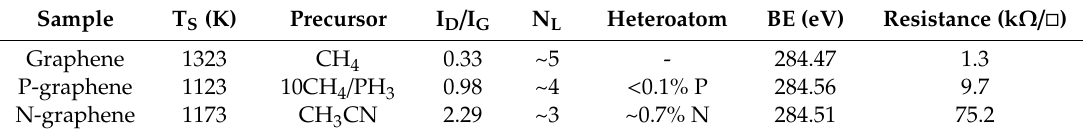
Table 1. Temperature (T S ) and precursor used for the sample synthesis, ratio of I D / I G from Raman scattering, number of layers (N L ), content of heteroatoms, and binding energy (BE) of C 1s peak determined from XPS data, and sheet resistance of the annealed samples.